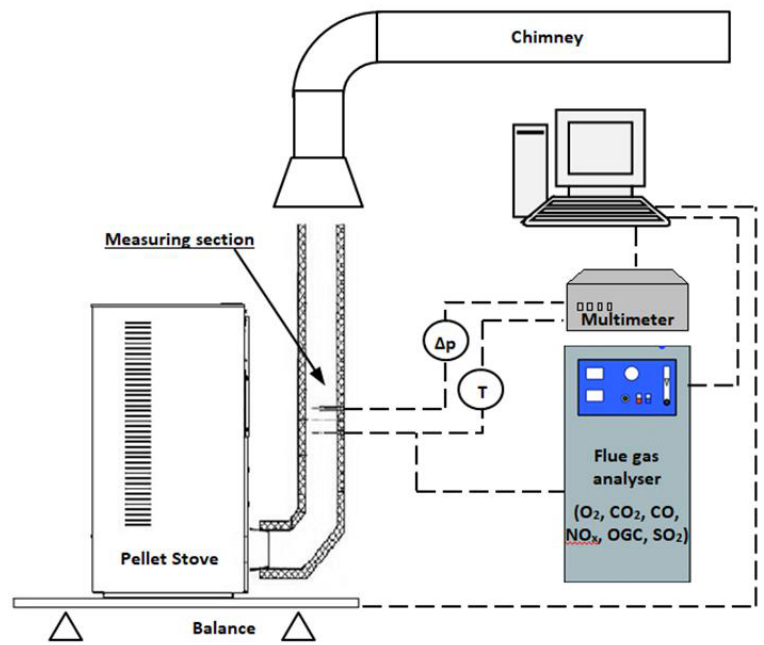
Figure 1. The schematic view of pellet combustion process.